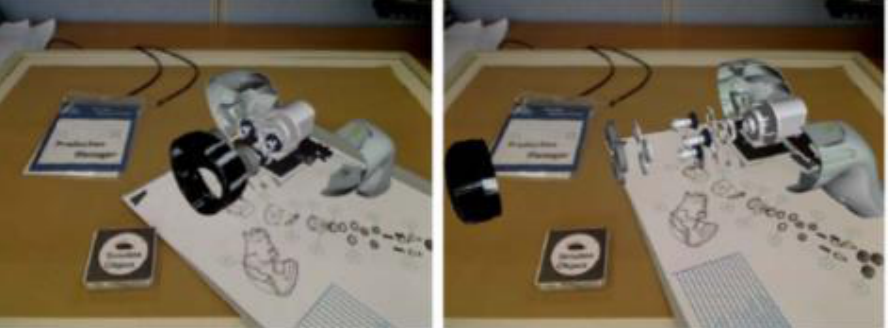
Figure 34. RFID-based tangible query for role-based visualization [58].